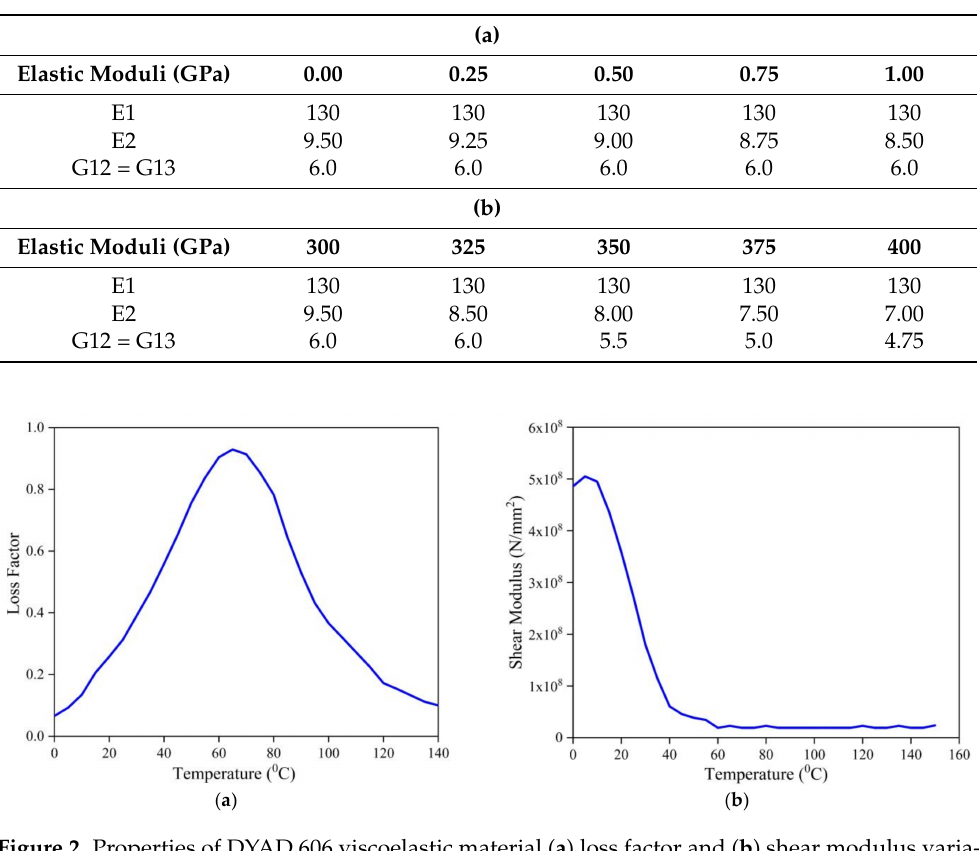
Table 2. ( a ) Properties of graphite–epoxy composite at different moisture concentrations G 23 = 0.5G 12 [38] (Adapted with permission from Elsevier B.V., License Number: 5077641188628). ( b ) Properties of graphite–epoxy composite at different temperatures G 23 = 0.5G 12 [38].